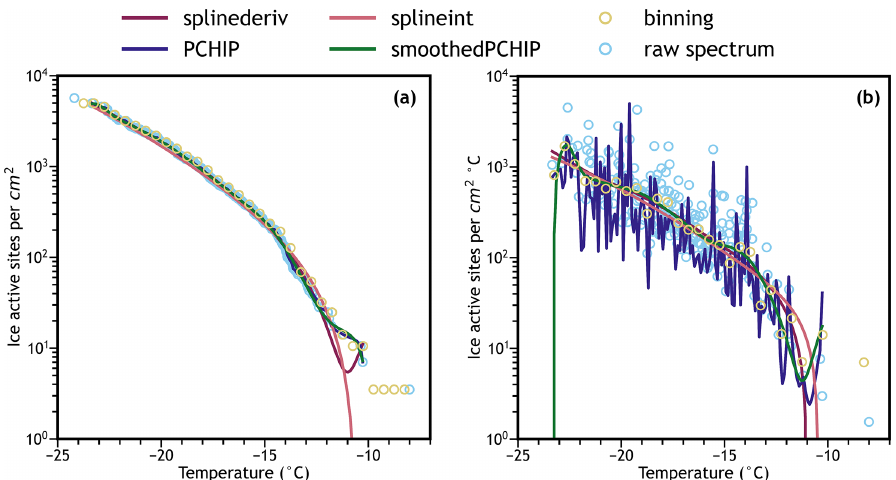
Figure 2. Comparison of interpolation methods on the water aged ash sample above in (a) cumulative and (b) differential spectra. Binning is accomplished by separating the temperature axis into “bins”, summing the number of freezing events in each bin, and then treating each bin as a single data point in Eqs. (1)–(3). Our preferred interpolation method is the smoothedPCHIP